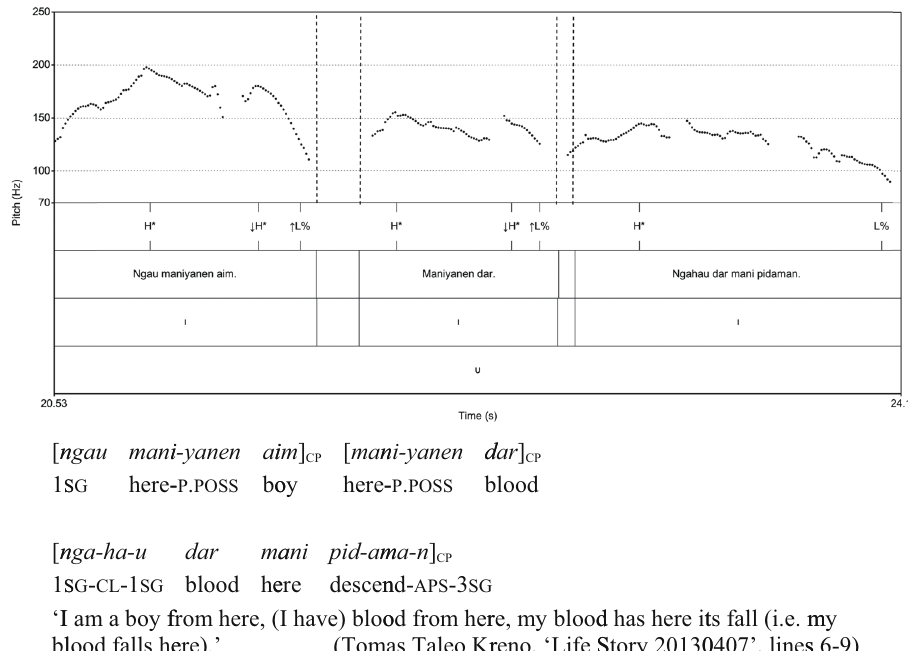
Figure 11: Three verbless clauses prosodically integrated into an utterance